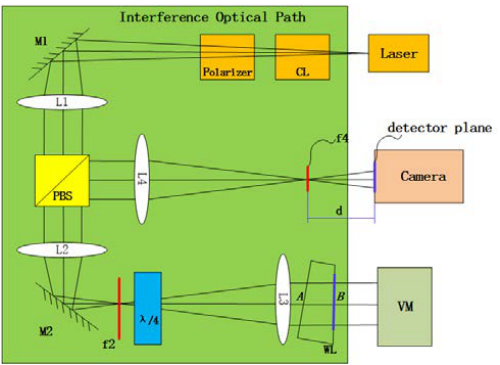
Figure 1. Schematic of multi-field interference (MFI) setup.